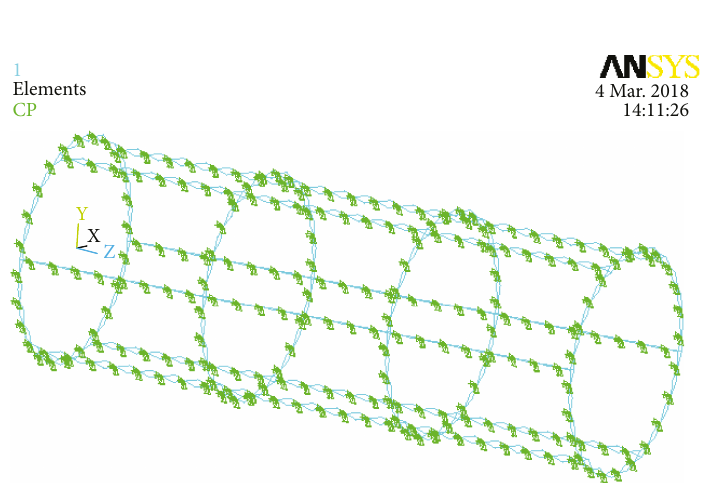
Figure 7: Model of freedom